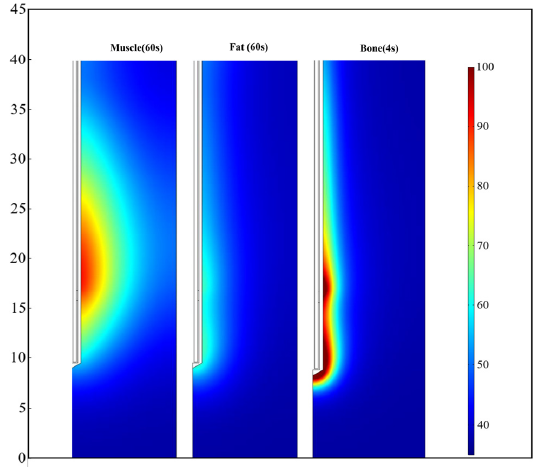
Figure 4. Temperature cloud map near ablation